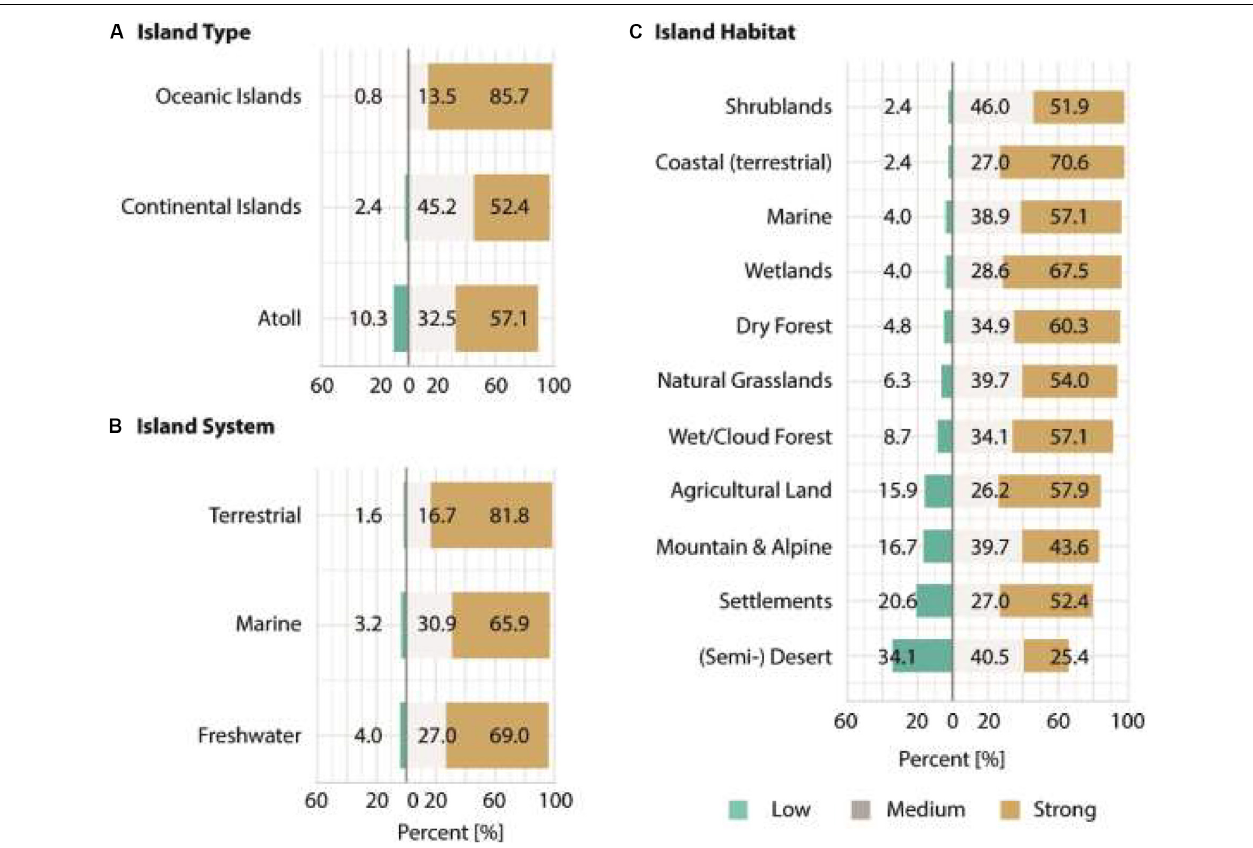
FIGURE 4 | Summary of the answers provided by the 126 respondents for the third section of the survey. Respondents were asked how strongly an increase in alien species richness in the 21st century will affect different (A) island types, (B) island systems, and (C) island habitats. Answers had to be provided on a 3-point Likert scale with the categories: low, medium, strong. Shown are the percentage results for each of the